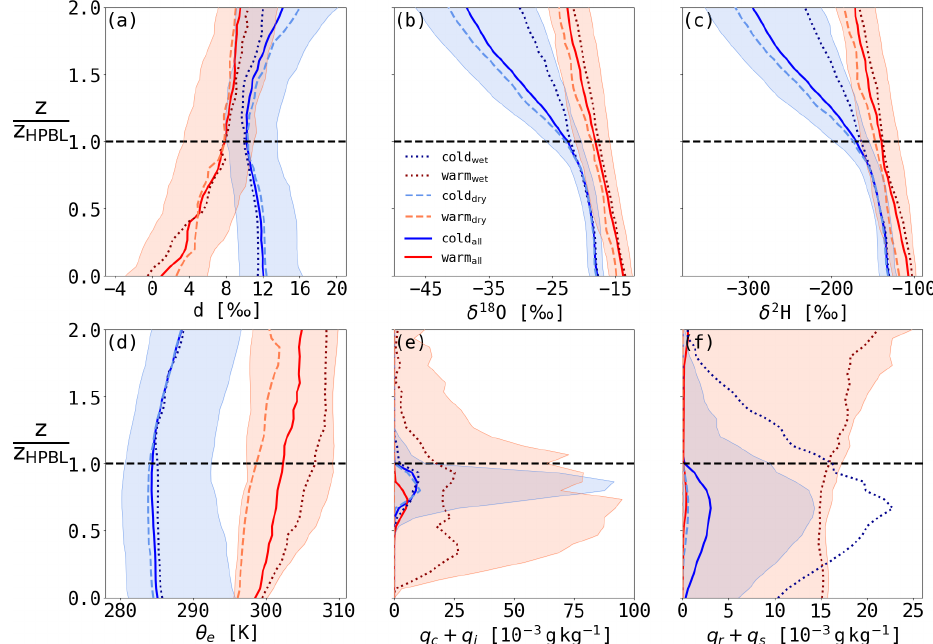
Figure 12. Composites of vertical profiles from COSMO iso showing the median of (a) d , (b) δ 18 O, (c) δ 2 H, (d) equivalent potential tem- perature θ e , (e) the sum of cloud and ice water content ( q c + q i ), and (f) the sum of rain and snow water content ( q r + q s ) for cold (blue) and warm (red) temperature advection events along the ACE ship track. The shading denotes the interquartile range. Furthermore, the median vertical profiles for conditions with (total surface precipitation R tot > 0.01mmh − 1 , dotted lines) and without (total surface precipitation R tot < 0.01mmh − 1 , dashed lines) surface precipitation are shown for warm and cold temperature advection. On the y axis the height relative to the boundary layer height is shown, where 1 denotes the height of the boundary layer (black dashed